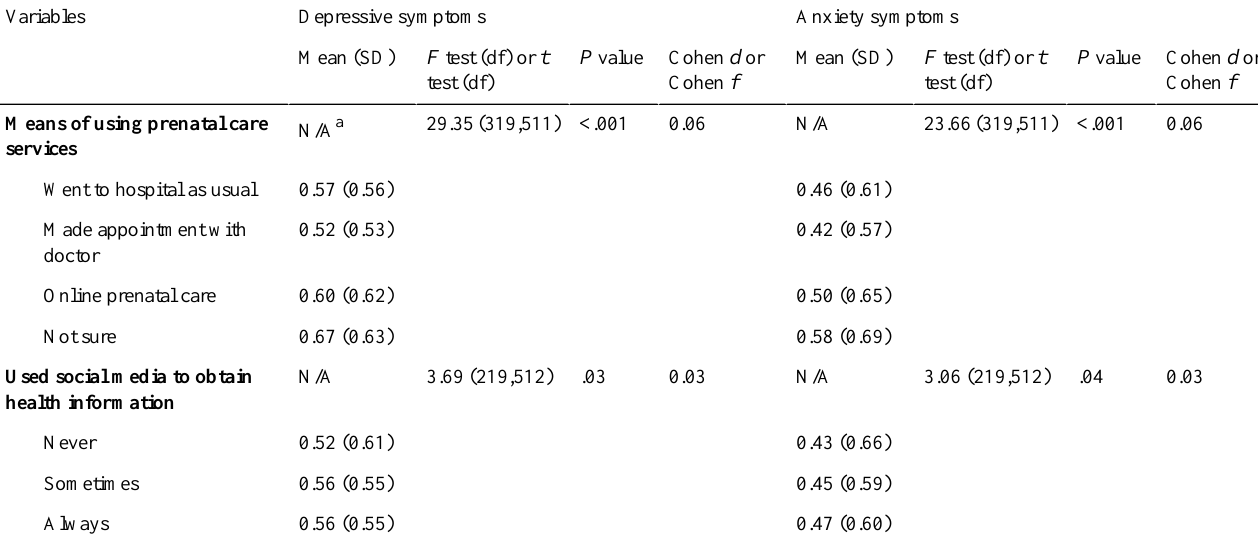
Table 5. Depressive and anxiety symptoms stratified by eHealth-related